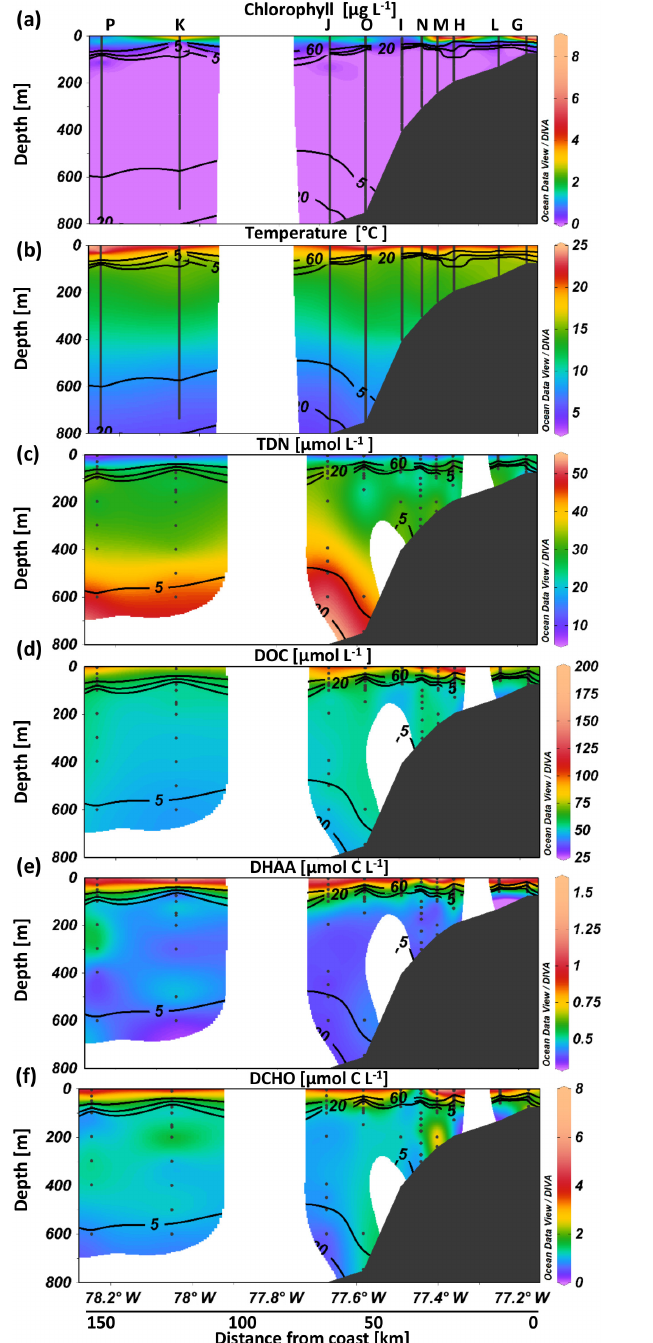
Figure 3. Biotic and abiotic conditions at selected stations ex- emplary for the sampling conditions. Chlorophyll (a) , tempera- ture (b) , total dissolved nitrogen (TDN) (c) , dissolved organic car- bon (DOC) (d), carbon content of dissolved hydrolyzable amino acids (DHAA) (e) and carbon content of high molecular-weight dis- solved carbohydrates (DCHO) (f) over depth at different stations from on- to offshore off